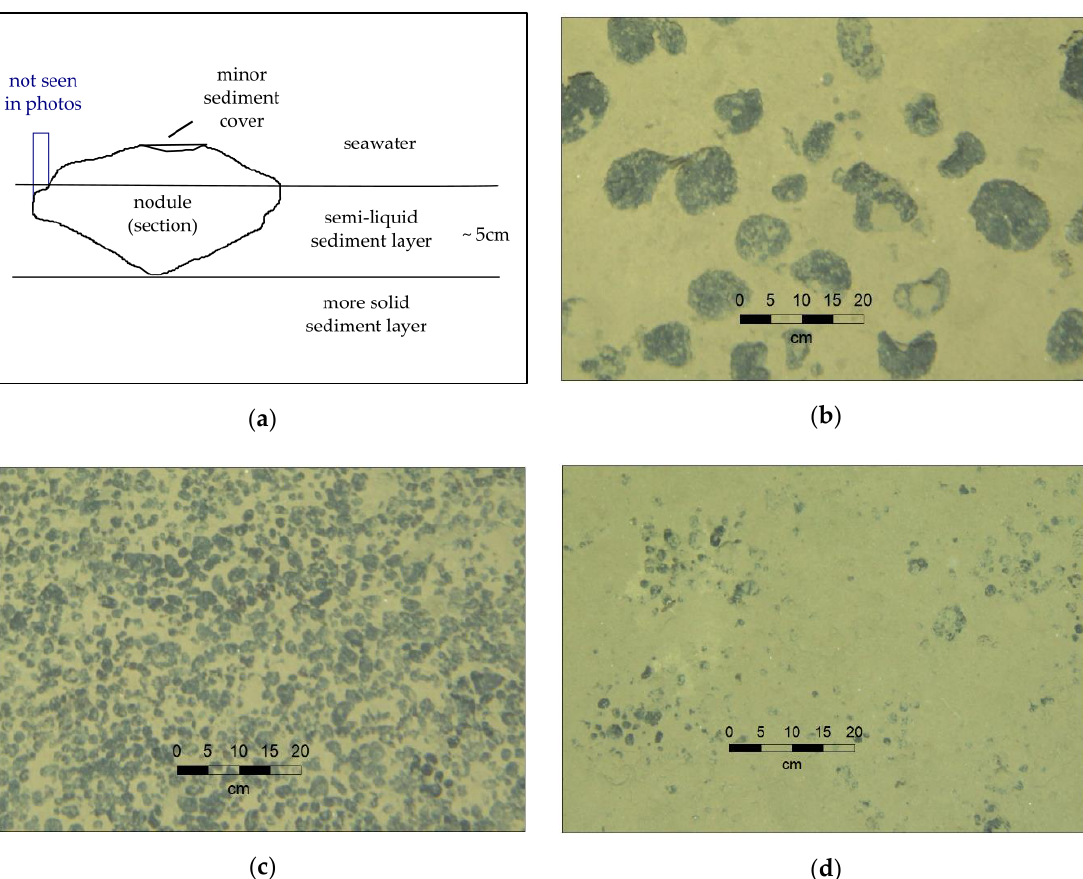
Figure 5. Polymetallic nodules on the seabed. ( a ) Schematic cross-section of nodules on the seabed; ( b ) example of large nodules (source: Tonga Offshore Mining Limited (TOML) image 2015_08_17_044250); ( c ) example of small nodules (source: TOML image 2015_08_17_105534); ( d ) example of covered nodules (source: TOML image 2015_09_16_183847) .